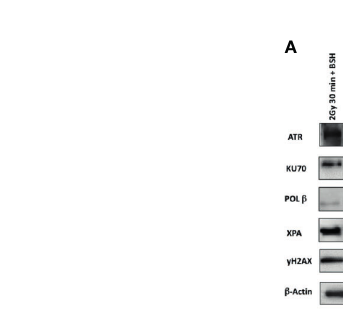
FIGURE 6 | Western Blotting analysis of DNA damage response in the MCF-10A cell line irradiated with 2 Gy of proton beam with or without BSH, studied at two time points: 30 min and 24 h post-irradiation. (A) Western Blot gel example with the studied proteins; (B) Fold change of protein expression. The data shown are representative of three independent experiments and are expressed as the mean ± standard error of the mean (SEM). The signi fi cance level compared to the untreated sample was set to p < 0.05 and displayed with the